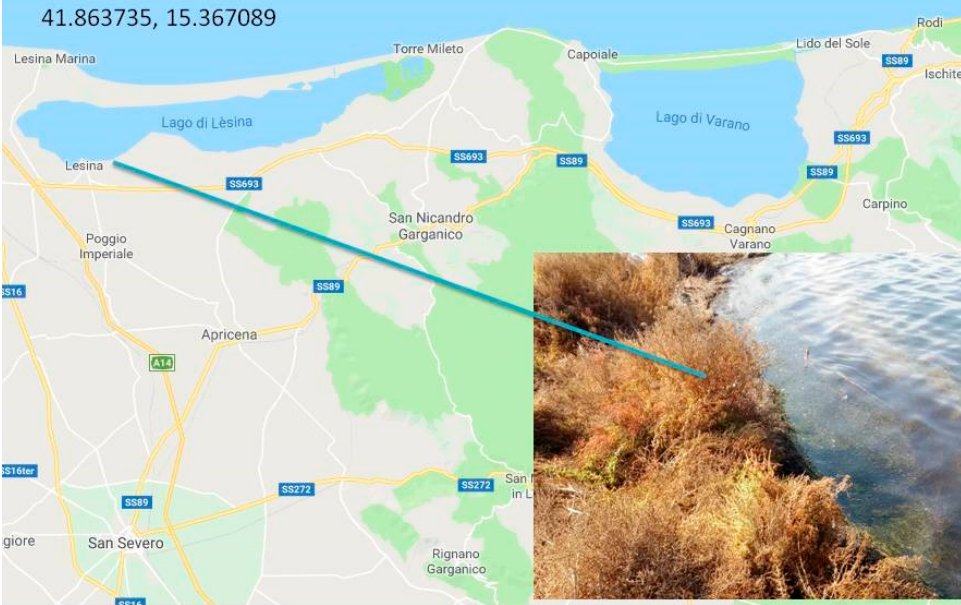
Figure 1. Salicornia europaea fuund at Lesina lagoon (Province of Foggia, Apulia, Italy). Table 1. Origin of some species belonging to Salicornia and Sarcocornia genus [12,14,15,16].